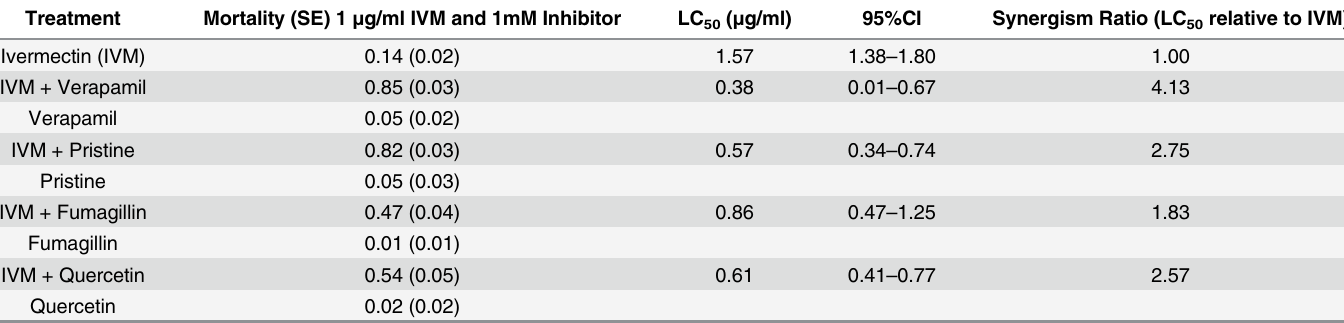
Table 1. Increased sensitivity of honey bees to ivermectin (1ug/ml) following oral exposure to standard and tested inhibitors (1mM) and LC50 of ivermectin following treatment of bees with 1 mM inhibitor solution. All inhibitor + ivermectin treatments had significantly higher mean mortality than the ivermectin treatment (p <